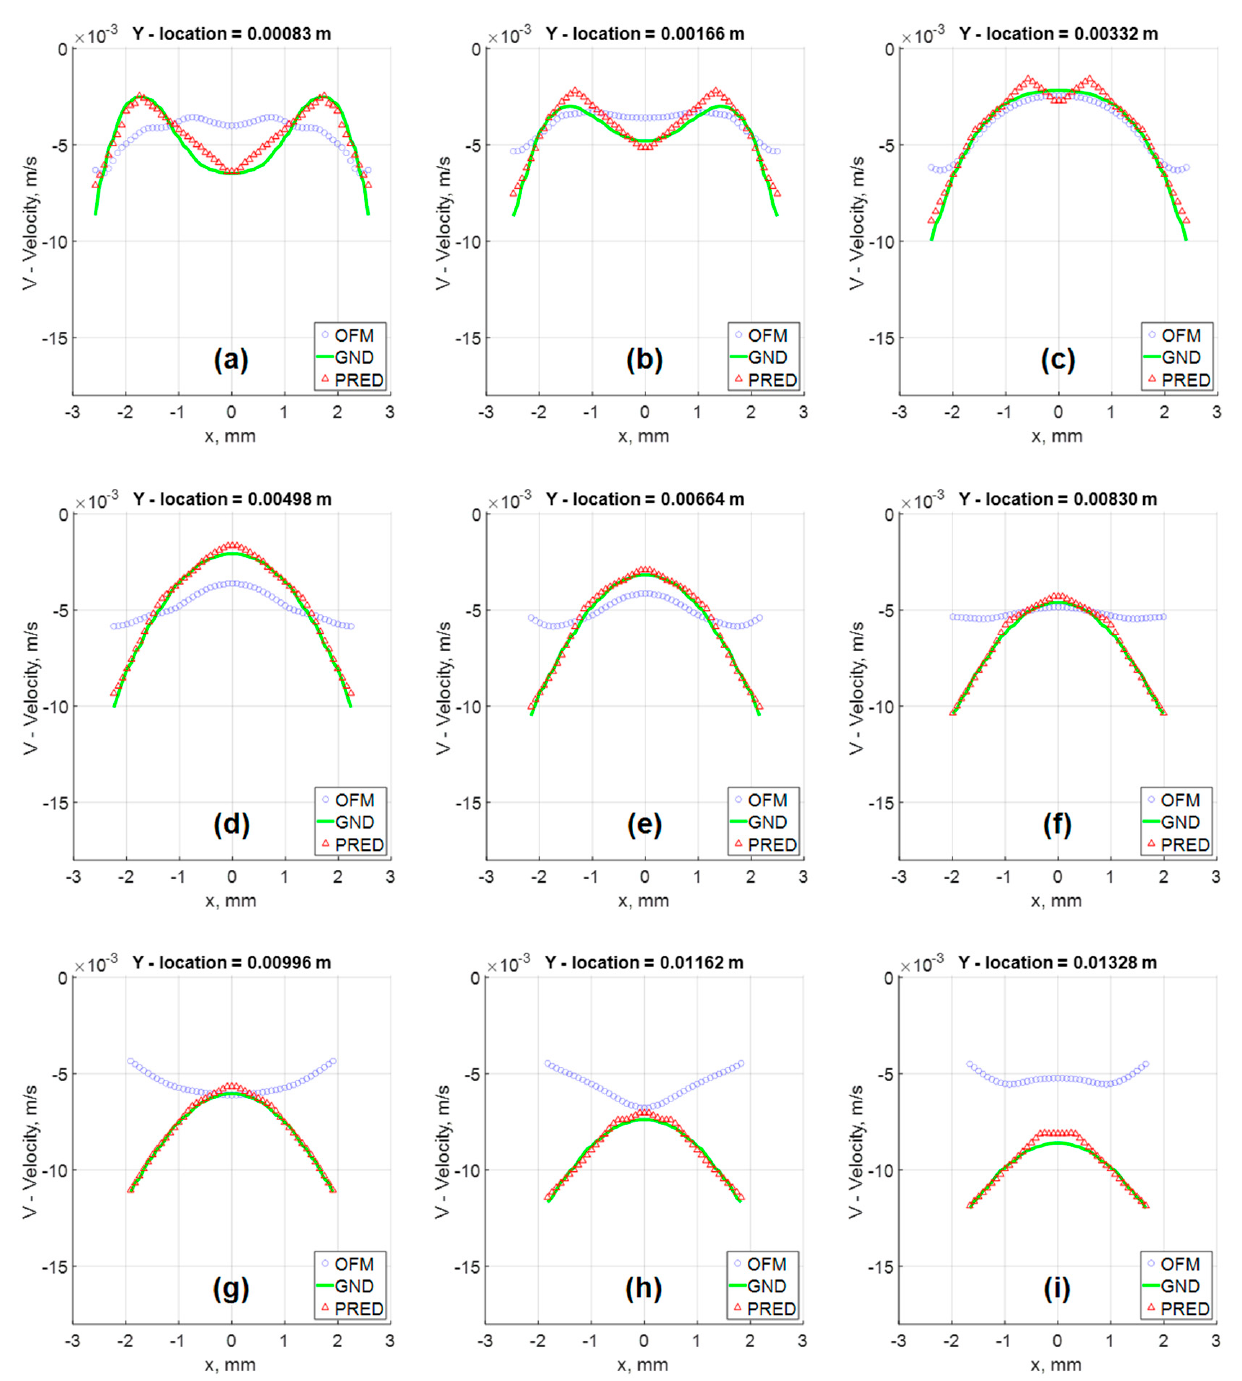
Figure 9. Velocity Vector fields comparison of in silico results at various Y locations: ( a ) Y = 0.00083 m; ( b ) Y = 0.00166 m; ( c ) Y = 0.00332 m; ( d ) Y = 0.00498 m; ( e ) Y = 0.00664 m; ( f ) Y = 0.00830 m; ( g ) Y = 0.00996 m; ( h ) Y = 0.01162 m; ( i ) Y = 0.01328 m.